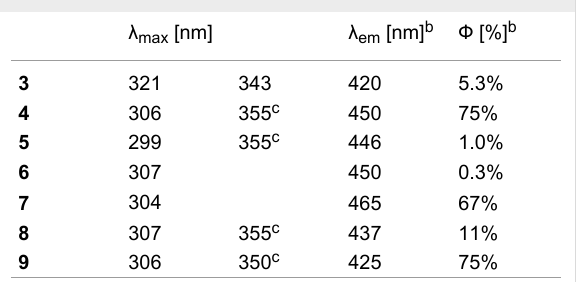
Table 2: Absorption and fluorescence spectroscopy data.